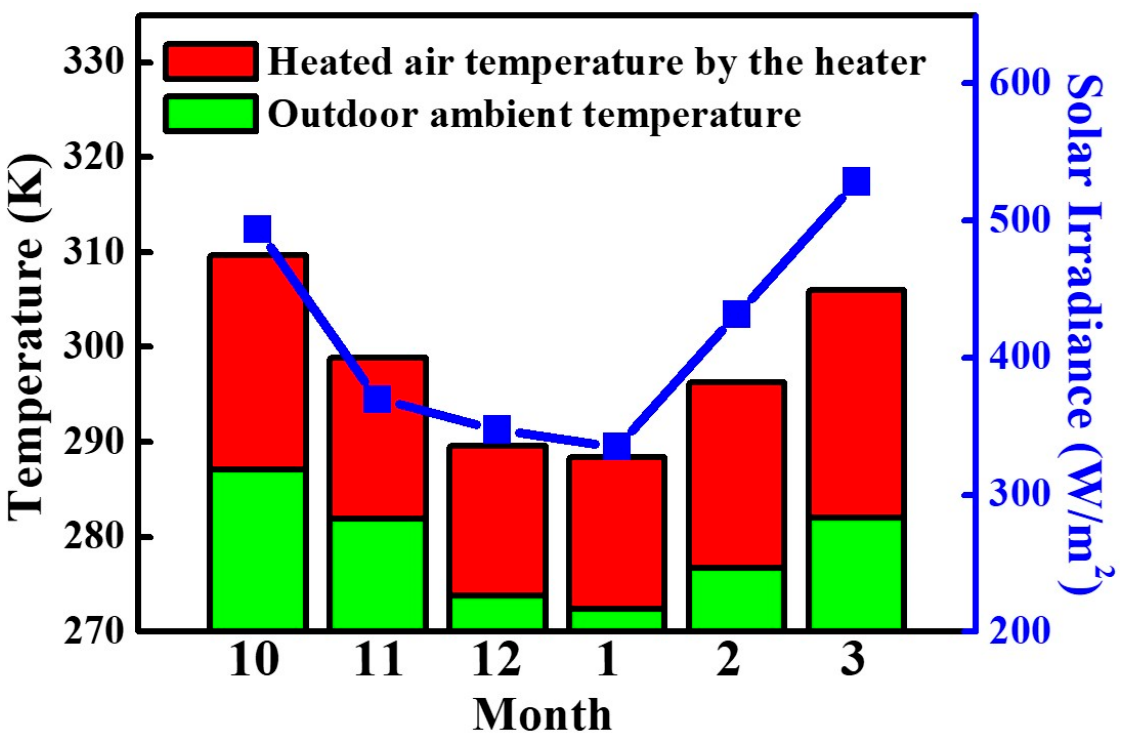
Figure 7. Maximum indoor heating temperature and heater outlet temperature according to monthly irradiance.